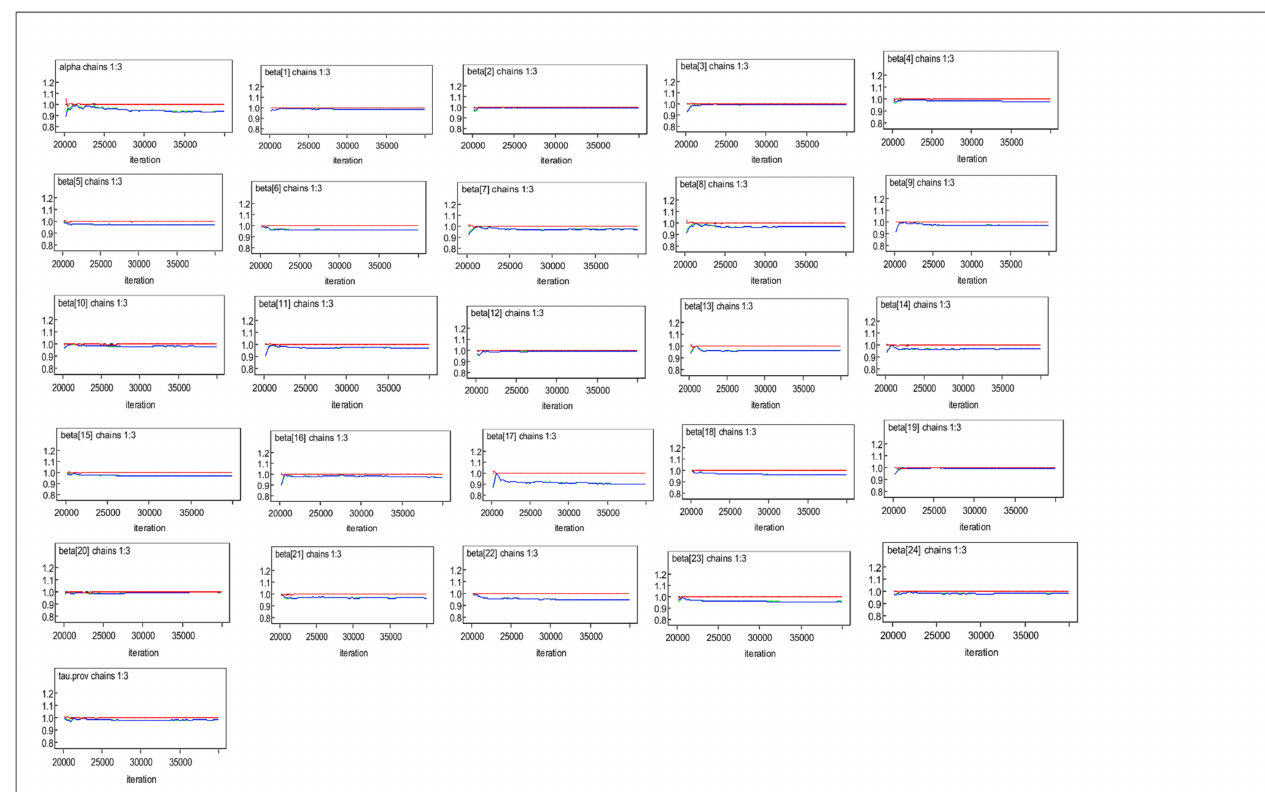
Figure A1. Density plots for Bayesian MLM with non-informative priors.